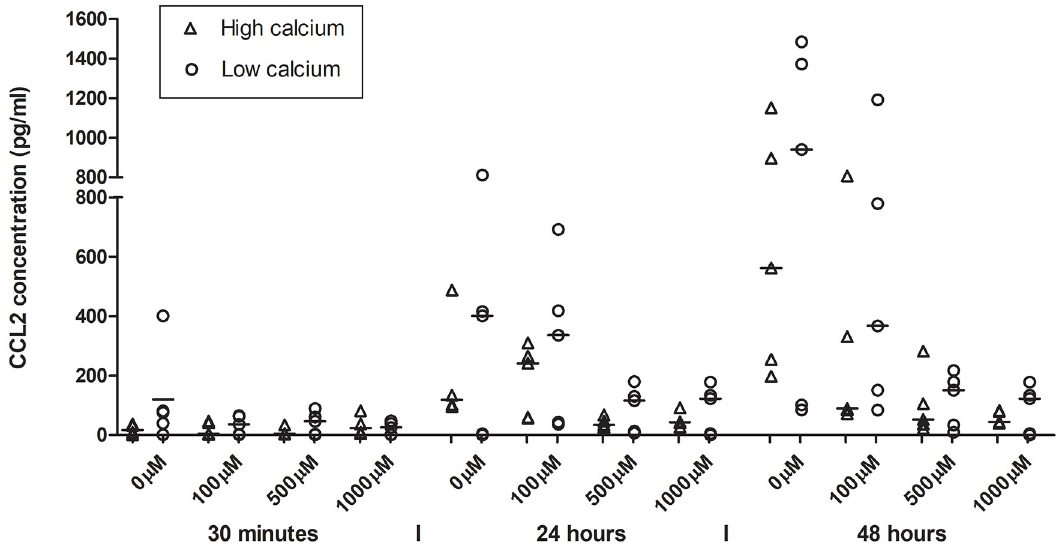
Fig 5. CCL2 secretion in HaCaT-cells after cobalt chloride exposure. HaCaT cells are exposed to cobalt chloride concentrations 100, 500 and 1000 μ M and an unexposed control (0 μ M). Time points are 30 minutes, 24 hours and 48 hours. The CCL2 secretion from the cells increased over time but decreased with increasing cobalt chloride concentration. This was seen for high (1.8 mM) and low (0.15 mM) calcium incubation conditions.